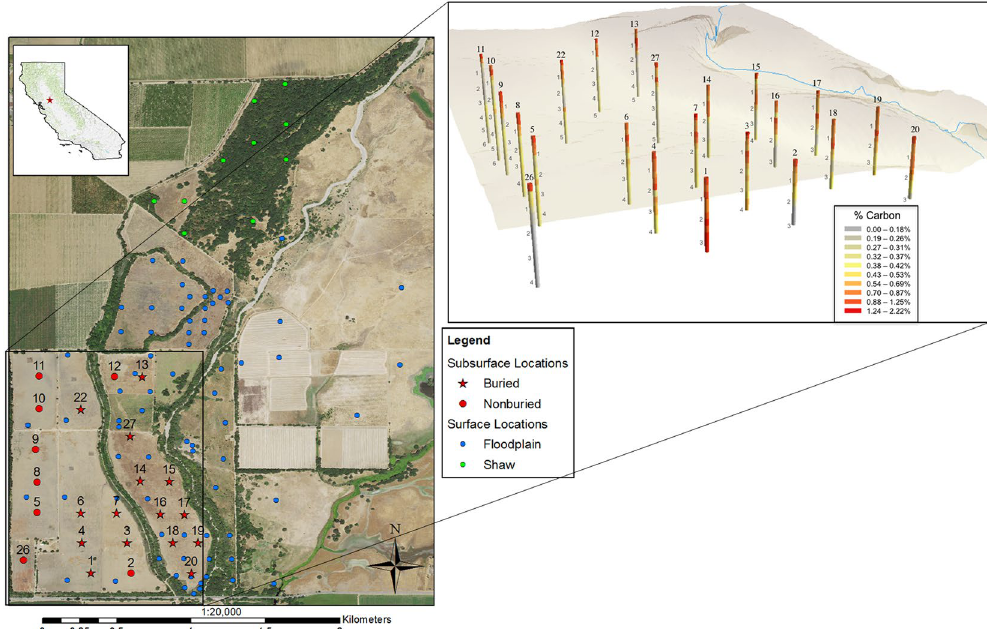
Figure 1. Map of the field site with (i) subsurface borehole sites as red stars (with a buried horizon) and red circles (without a buried horizon) and (ii) surface sample sites in dark blue (floodplain ecosystem) and light blue (Shaw forest ecosystem). The offset map shows the subsurface carbon distribution at depth where gray vertical numbers indicate depth (m), red indicates higher carbon and gray indicates lower carbon. Both maps were created with ArcGIS version 10.4.1